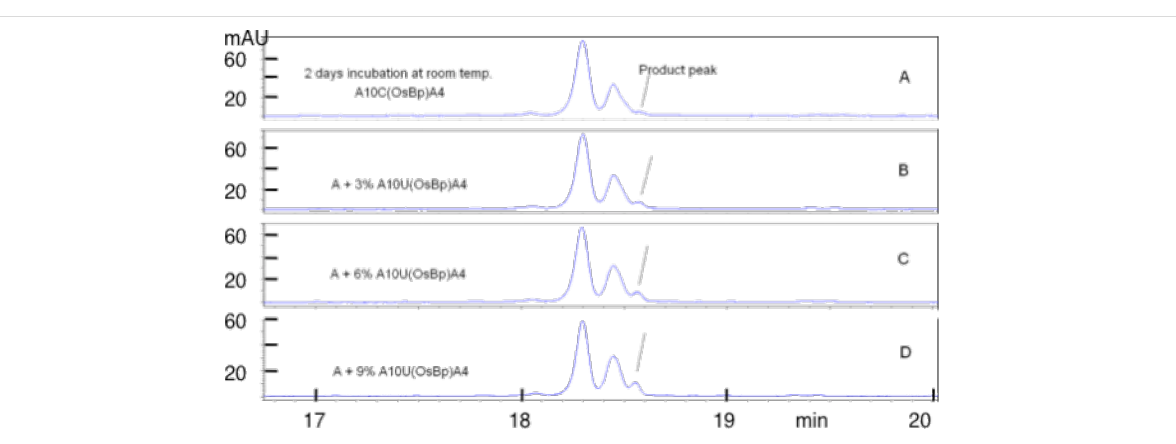
Figure 12: CE profiles: (a) after two days of incubation at room temperature a small shoulder appears at the mt position where the corresponding U-oligo would appear, suggesting negligible, if any, degradation of C(OsBp) to U(OsBp). (b–d) confirm by spiking with increasing amounts of U-oligo that this minor product/degradant peak comigrates with the smaller of the two isomers of A 10 U(OsBp)A 4 , and its increase over time would have been clearly detectable.